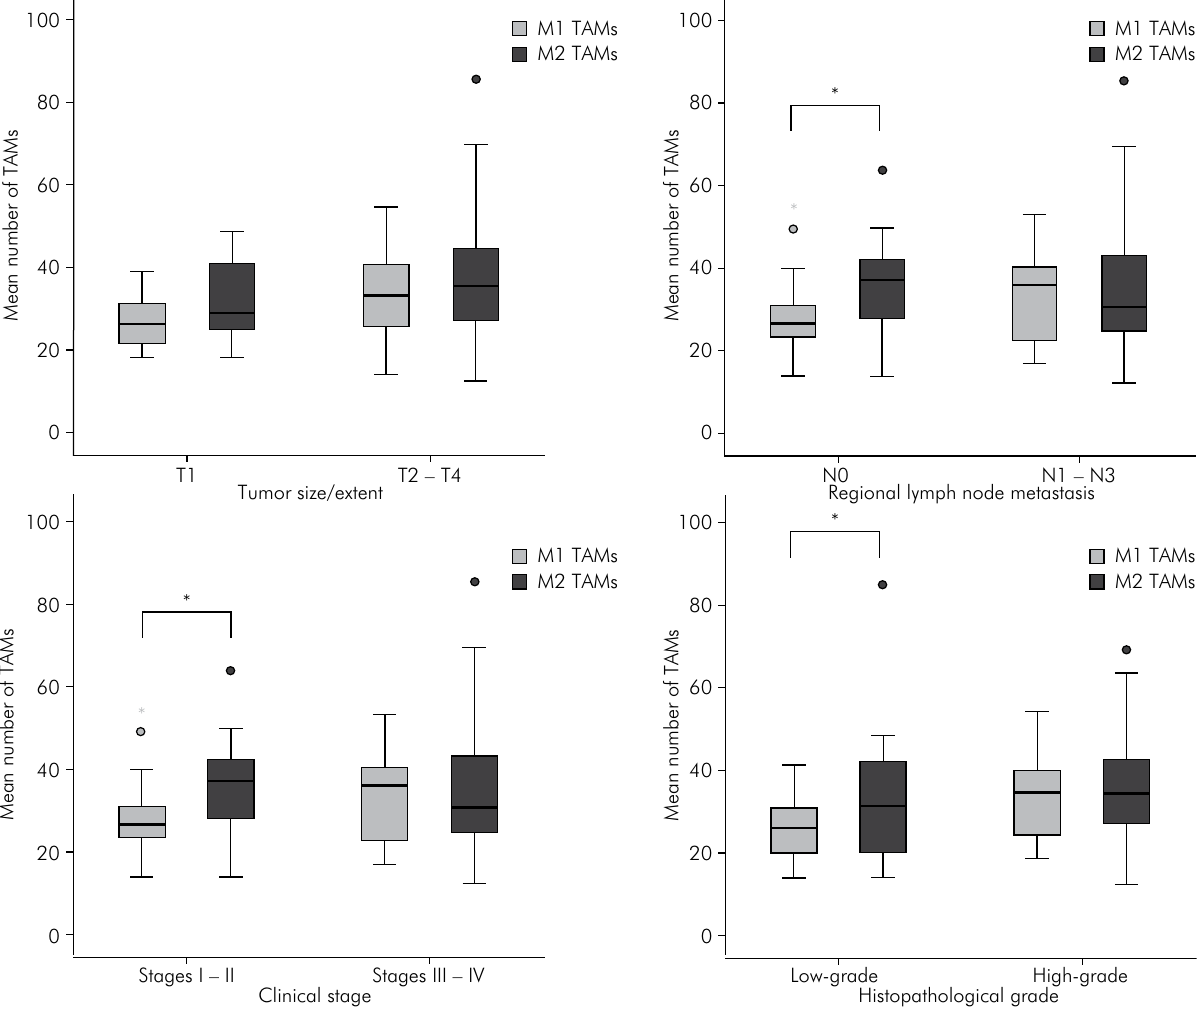
Figure 3. Box plot charts illustrating the number of M1 and M2 TAMs in SCCLLs according to tumor size/ extent, regional lymph node metastasis, clinical stage, and histopathological grade of malignancy. *Statistical difference (p < 0.05; Wilcoxon signed rank